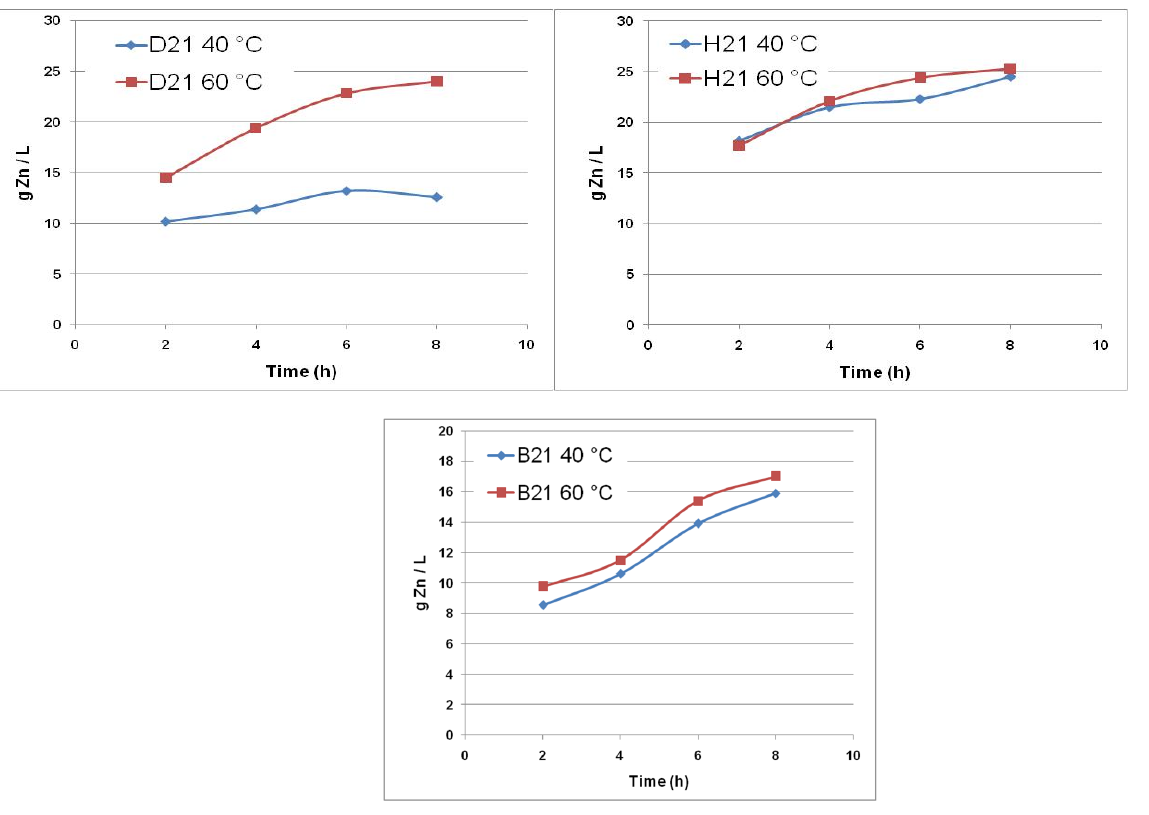
Figure 8. The temperature dependence of zinc content in leaches during leaching in 500 mL of 20% NaOH solution (a sludge weighed amount was always 125 g). Table 16. The conditions for the electrolysis of the leaches from three suppliers, the cathode—a stainless plate; the anode—a nickel plate.